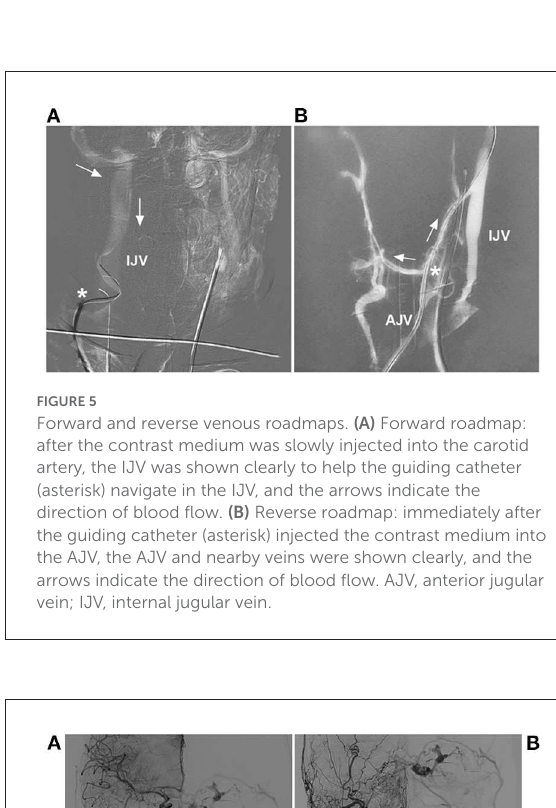
FIGURE7 Operative angiography of CS-DAVF embolized via the trans-IJV-FV-SOV route. (A) Angiography of the left ECA via the transarterial diagnostic catheter showing that the transvenous therapeutic guiding catheter (asterisk) was placed into the IJV. (B) Angiography of the left ECA shows that the microcatheter was advanced into the FV (asterisks) via the transfemoral trans-IJV-FV route. (C) Venous navigation roadmap shows that the microcatheter passed through the angular vein and SOV into the CS (arrow). (D) Unsubtracted angiography showing coiling (frame) was performed; the picture in the picture (right angle arrow) shows the combined use of Onyx. (E, F) Post-TVE angiographies of the left carotid artery (E) and right carotid artery (F) show complete occlusion of the DAVF. CS, cavernous sinus; DAVF, dural arteriovenous fistula; ECA, external carotid artery; EJV, external jugular vein; FV, facial vein; IJV, internal jugular vein; L, left; R, right; SOV, superior ophthalmic vein; TVE, transvenous embolization. After the microcatheter reaches the fistula